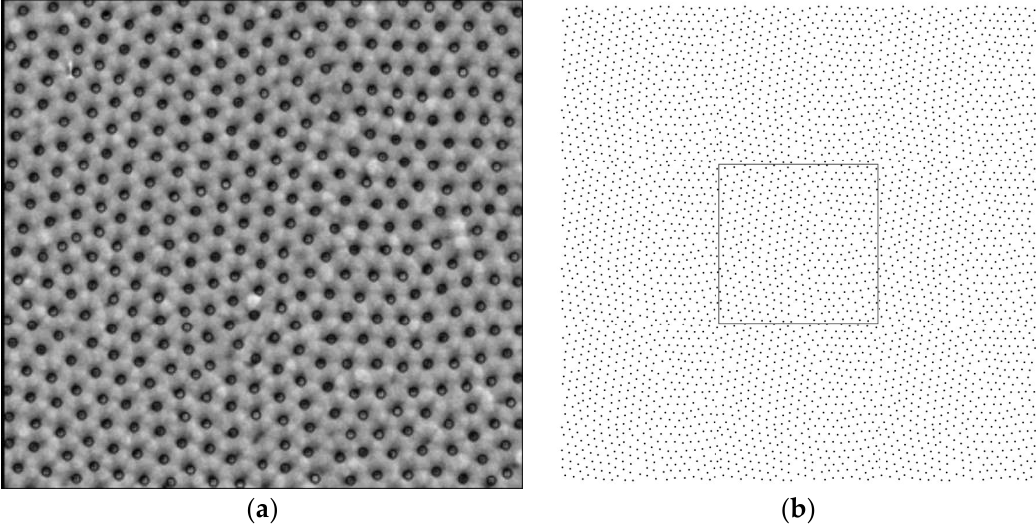
Figure 1. ( a ) Photograph of the sample of porous aluminum oxide layer from [8]. Circles around pore centers are plotted. ( b ) Array of pore centers obtained by a parallel translation of the pore centers in the initial array along the coordinate axes and the diagonals of the sample. The region containing pore centers in the starting sample is selected by a rectangle.